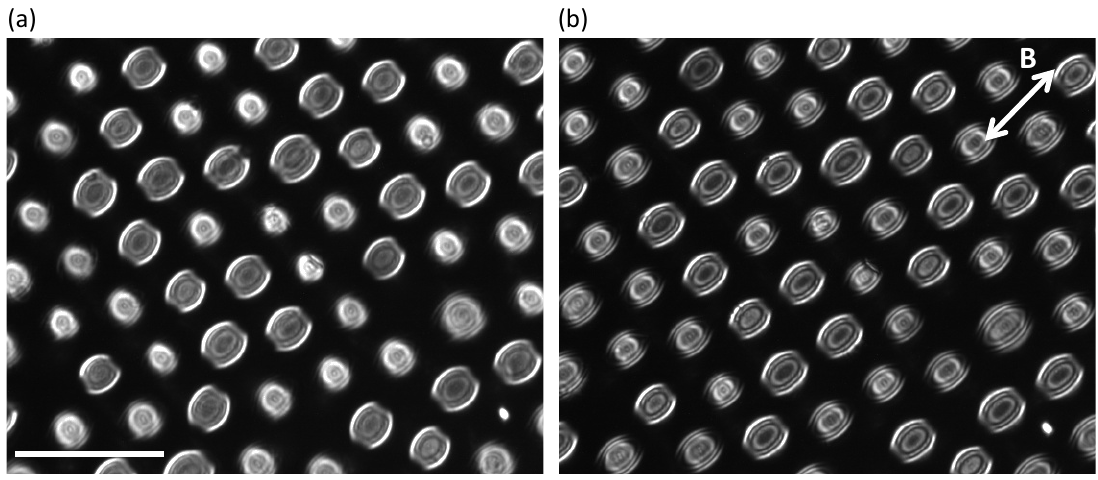
Figure 6. ( a ) SSY nematic droplet assembly suspended in fluorinated oil inside a chamber of height 125 µ m. ( b ) The assembly is placed inside a 0.4 T magnetic field resulting in a reorientation of the nematic droplets. Scale bar is 100 µ